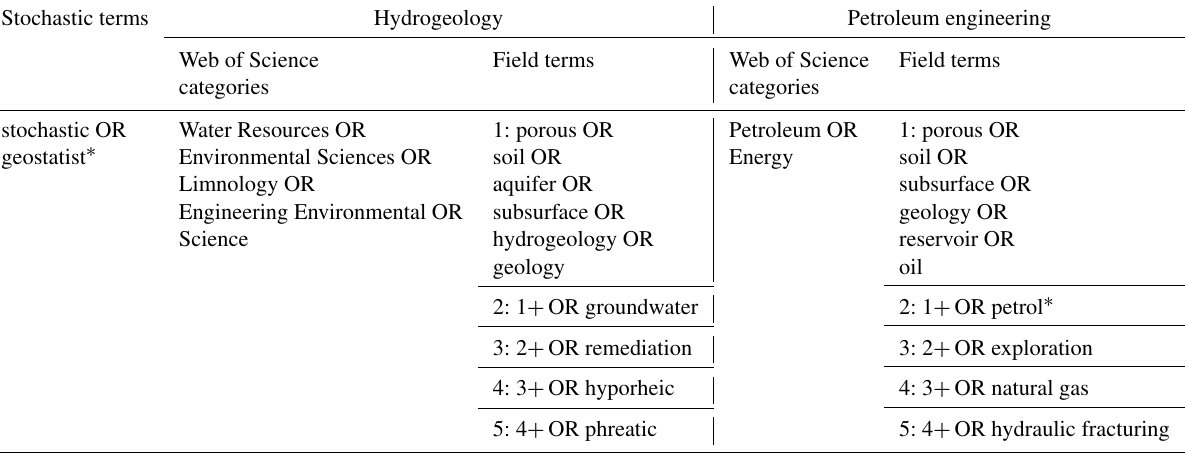
Table A1. Web of Science search terms used to compare hydrogeology and petroleum engineering documents. The stochastic terms (leftmost column) were used for all search sets. For hydrogeology, the searches were limited to the Web of Science categories listed in the second leftmost column. The five search sets for hydrogeology are listed in the middle column and are composed of the search terms listed. The search sets vary by incrementally more search terms related to hydrogeology. Similarly, the Web of Science categories and search term sets for petroleum engineering are listed in the two rightmost columns. Each search set consists of combining the stochastic terms, the Web of Science categories, and field terms with a logical AND operator via the Web of